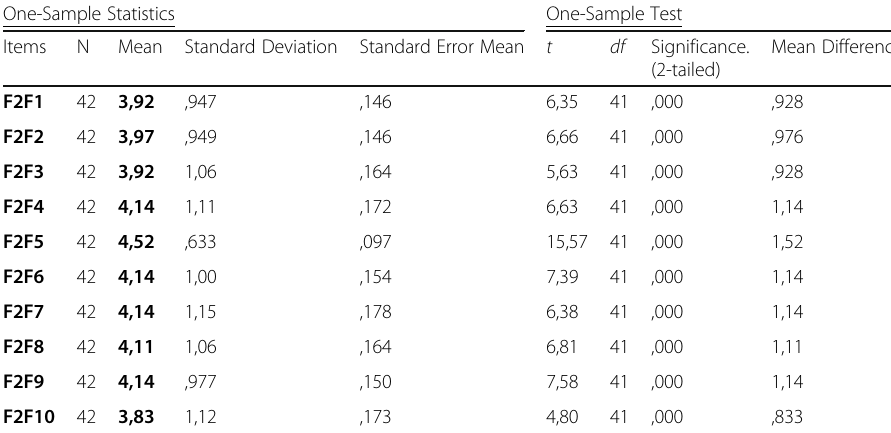
Table 4 One sample t -test for Face-to-face Learning Environment. Items in bold are significant One-Sample